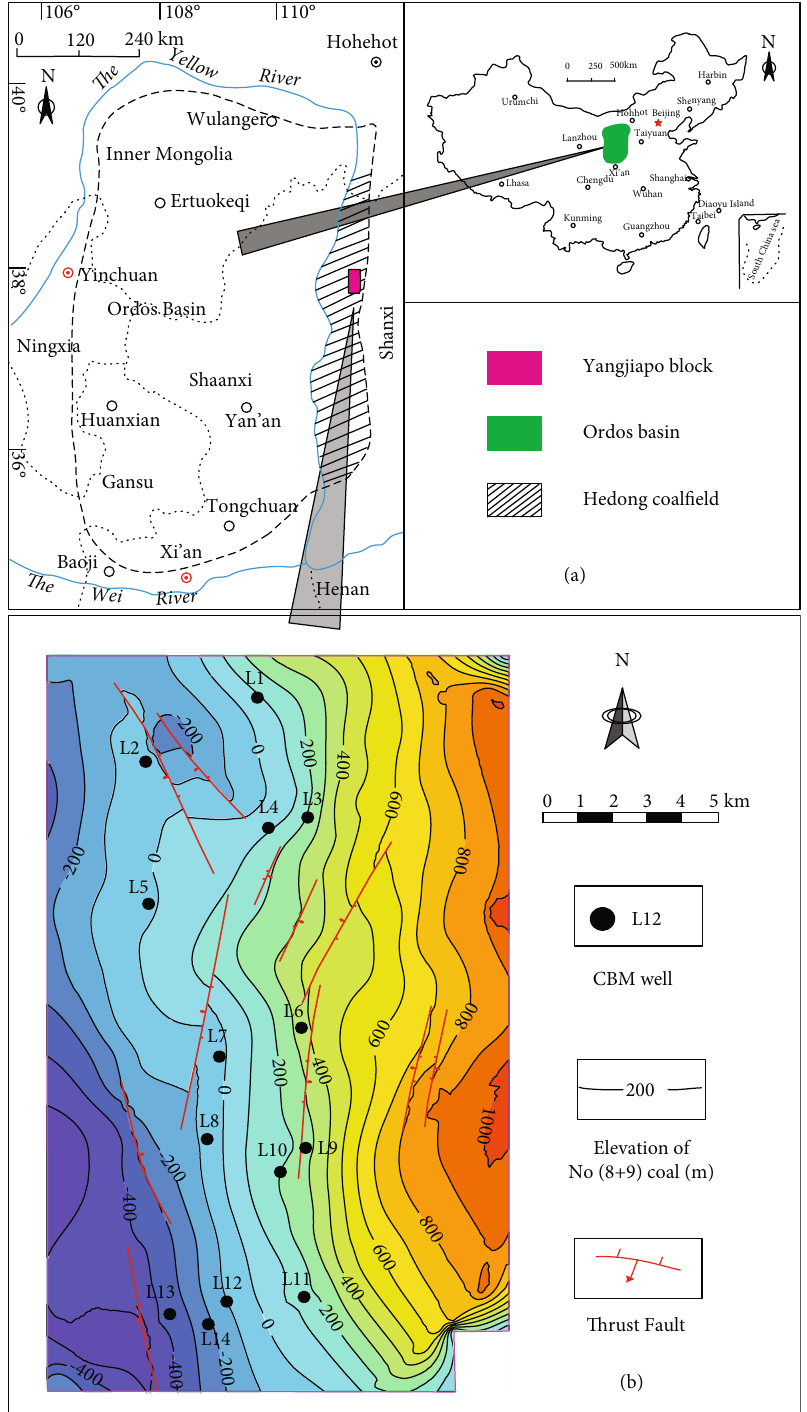
Figure 1: (a) Location of the Ordos Basin and Yangjiapo block. (b) Structural elevation of the bottom of No. ( 8 + 9 ) coal seam in Yangjiapo